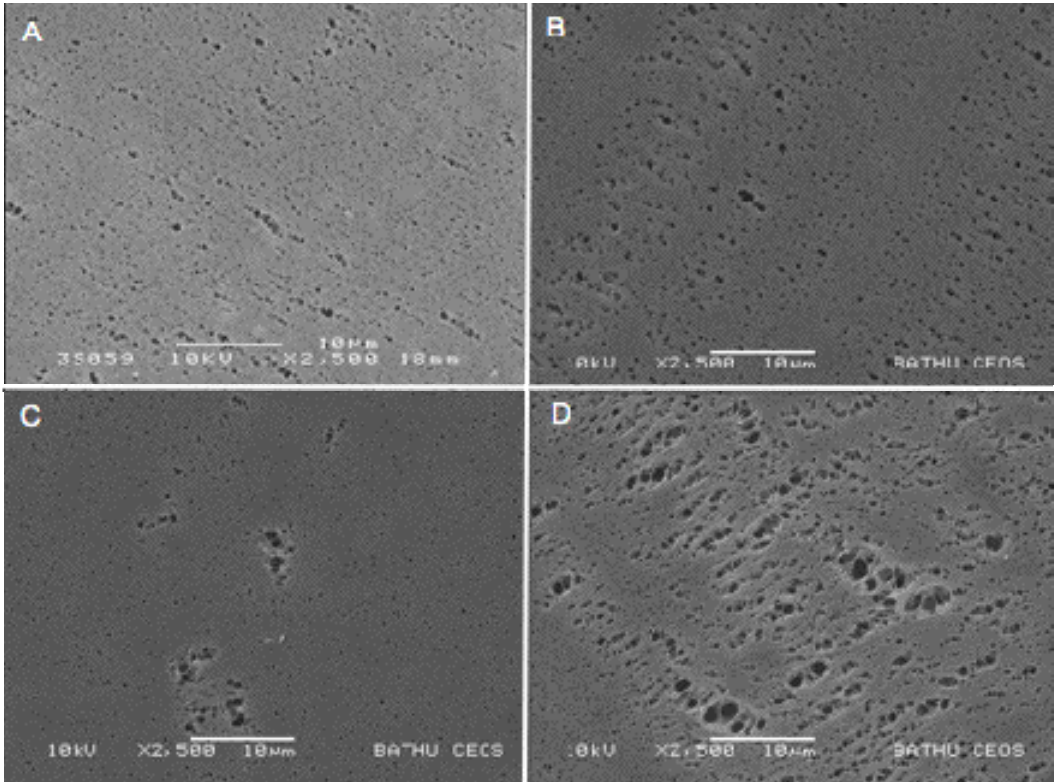
Figure 2. Surface morphology of PLGA membranes with different simvastatin